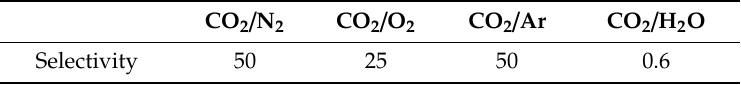
Table 13. Membrane selectivity with respect to CO 2